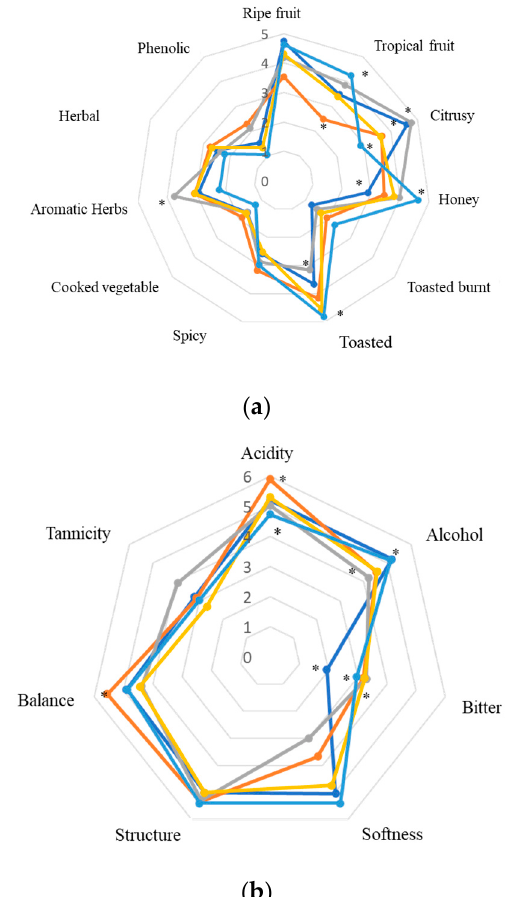
Figure 3. Sensory analysis of Verdicchio wine fermented by S. bombicola ( ); L. thermotolerans ( ); Spontaneous fermentation ( ); T. delbrueckii / L. thermotolerans/S. bombicola ( ) and S. cerevisiae ( ). ( a ) smell analysis, ( b ) taste analysis. *, Significantly different (Fisher ANOVA; p -value < 0.05).